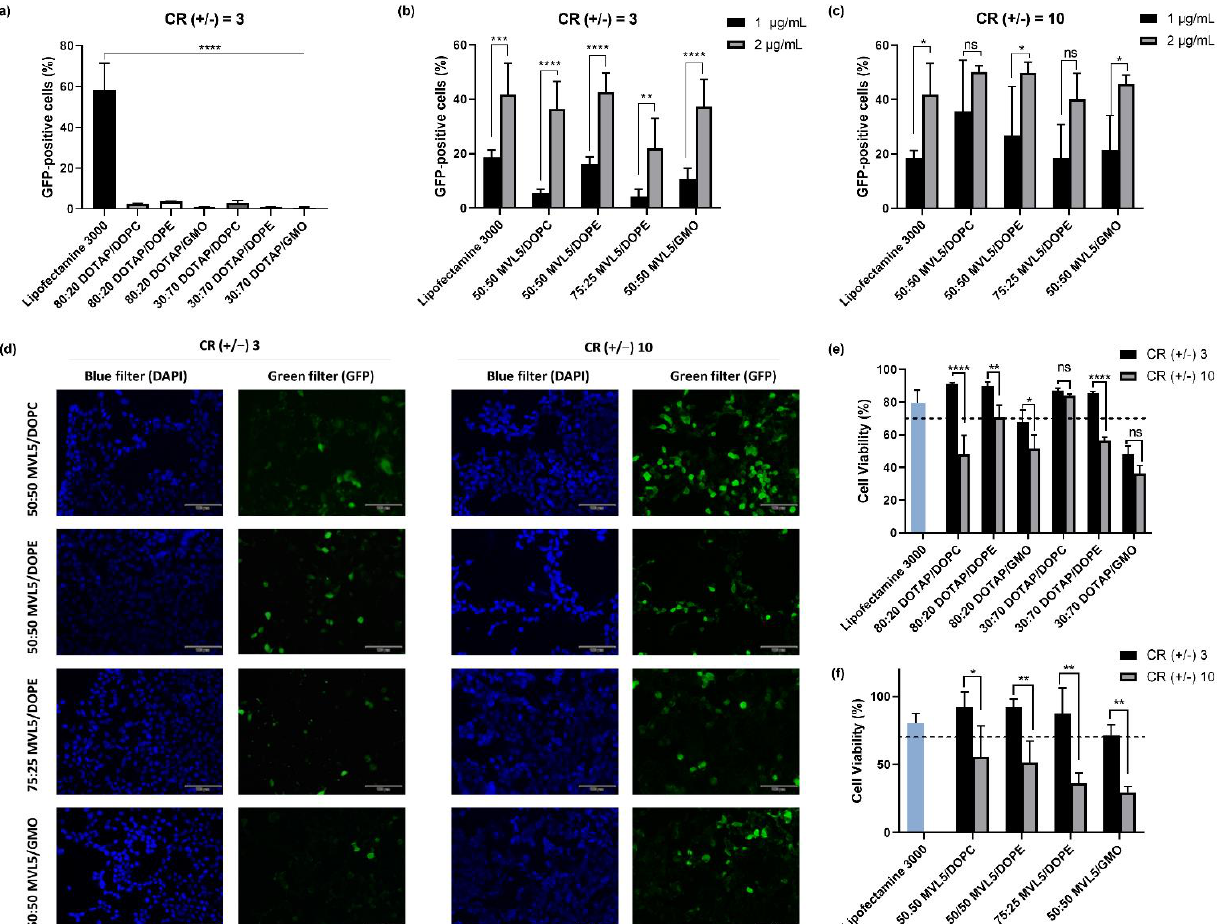
Figure 3. In vitro transfection and cytotoxicity in HEK 293T cells transfected with the Cas9/sgRNA- GFP plasmid (PX458). The percentage of GFP-positive cells was measured by flow cytometry. The data are expressed as the mean ± SD ( n = 3). ( a ) Transfection efficiency of DOTAP-based lipoplexes at CR (+/ − ) 3. One-way ANOVA indicates statistically significant differences within the group assessed by Dunnett’s multiple comparisons test and denoted as follows: **** p ≤ 0.0001. ( b , c ) Transfection efficiency of MVL5-based lipoplexes at a CR (+/ − ) of 3 and 10, respectively. ( d ) Fluorescence microscopy images of HEK 293T cells transfected with 2 µ g/mL of PX458 plasmid via multivalent CL-DNA complexes. Scale bars correspond to 100 µ m. ( e , f ) Cytotoxicity profile of monovalent (DOTAP) and multivalent (MVL5) lipoplexes, respectively, as evaluated by the MTT assay. HEK 293T cells were transfected with lipoplexes containing 0.1 µ g of PX458. Untreated cells were used as a negative control (100% viable cells). The dashed line corresponds to 70% of cell viability. Data are expressed as the mean ± SD ( n = 3). Two-way ANOVA indicates statistically significant